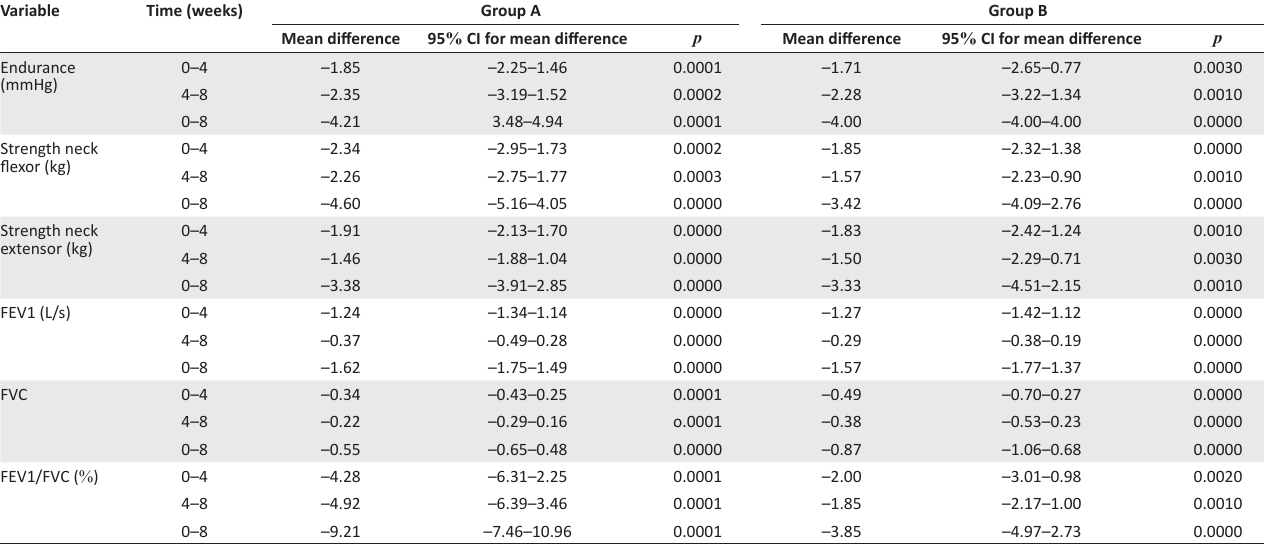
TABLE 3: Pair wise comparison between two groups at different time points. Variable Time (weeks) Group A Group B Mean difference 95 % CI for mean difference Mean